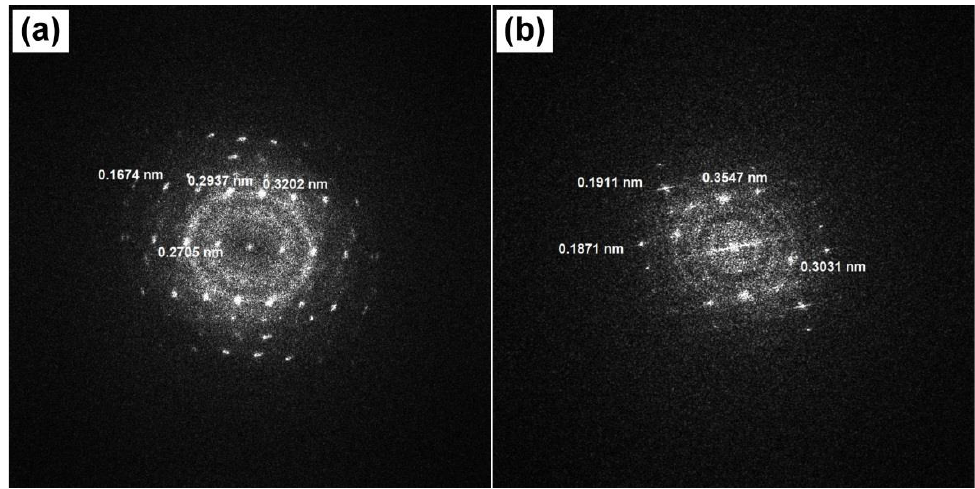
Figure 6. The FFT patterns of 10%V/C12A7 sample: ( a ) mayenite particle shown in Figure 5a; ( b ) calcium vanadate particle shown in Figure 5d.